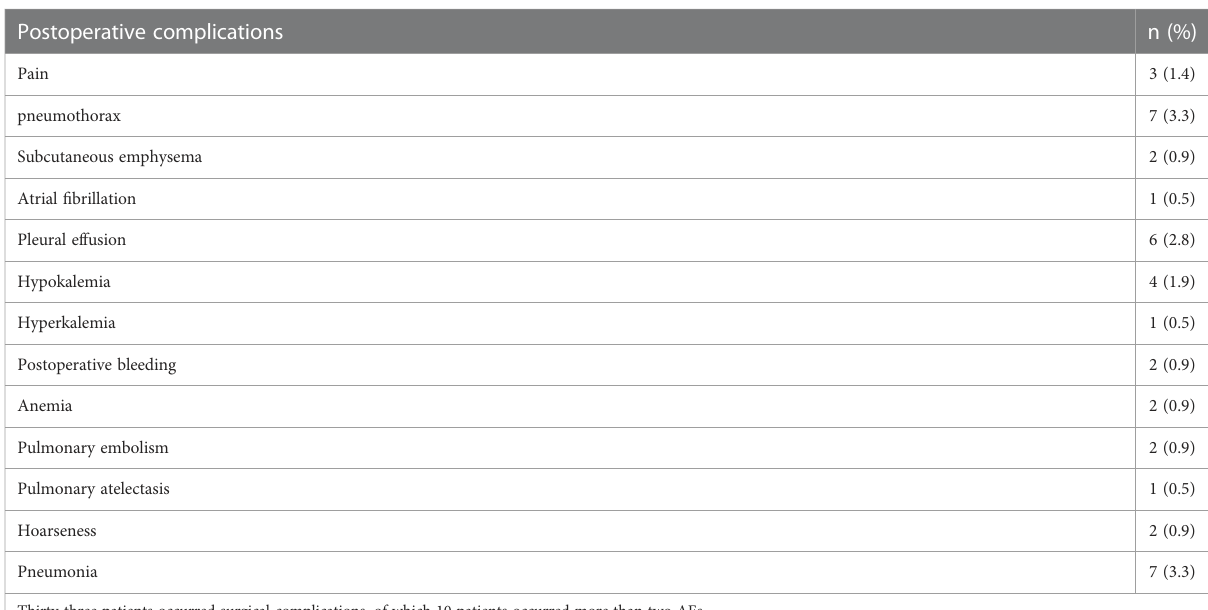
TABLE 4 Surgery-related adverse